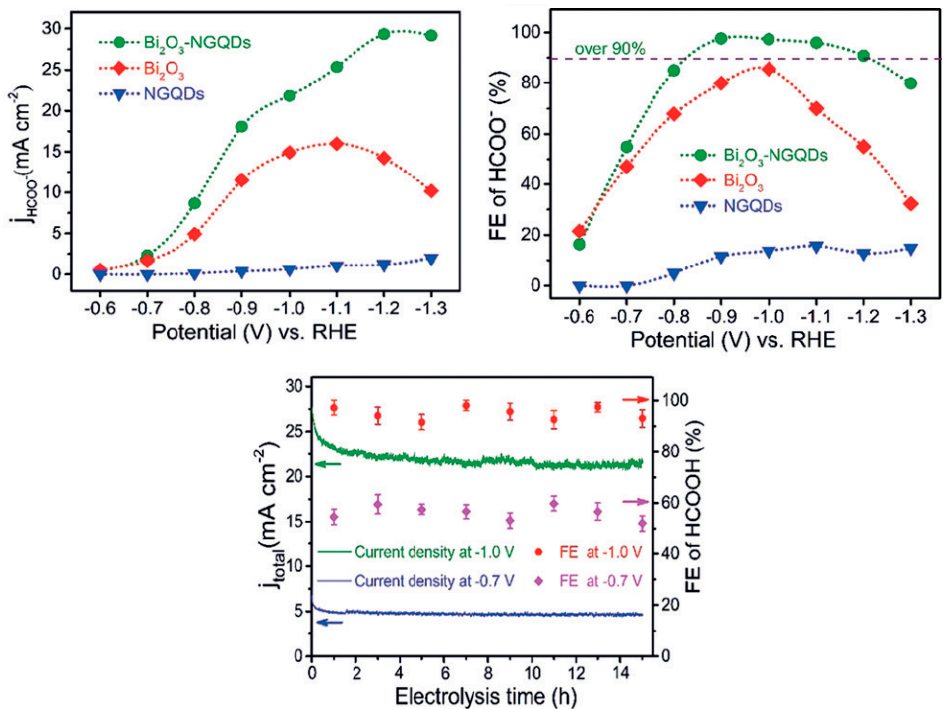
Figure 4. Faradaic efficiency (FE) and formate partial current density for Bi 2 O 3 -NGQD (nitrogen-doped graphene quantum dot), Bi 2 O 3 , and NGQD at different potentials (upper panels) and long-term electrolysis experiments of Bi 2 O 3 -NGQD recorded at − 0.7 V and − 1.0 V (bottom panel) in a 0.5 M KHCO 3 electrolyte. Reproduced with permission [35].